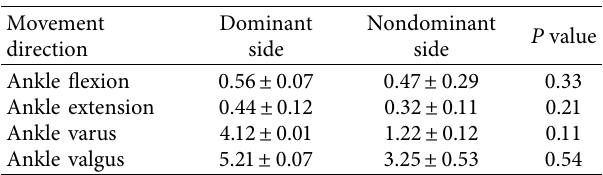
Table 4: Cell proliferation.